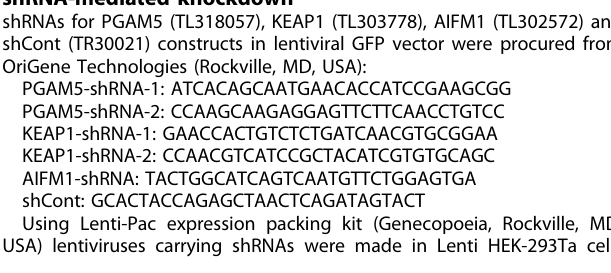
Fig. 7 Oxeiptosis is involved in SNG-induced tumor suppression in vivo. Mice were subcutaneously inoculated with HT-29 cells into the right fl anks and randomly divided into two groups ( n = 5). Mice were injected intraperitoneally (i.p.) with 6 mg/kg/ SNG or an equal volume of vehicle. A Individual value plot showing the weights of HT-29 tumor xenografts in the vehicle and SNG treatment groups. Data shown are mean ± SD ( n = 5) (** p < 0.01). B Tumor volumes of HT-29 xenograft tumors with the different time points (days) after exposure to SNG. Data shown are mean ± SD ( n = 5) (*** p < 0.001). C Western blot analysis of indicated proteins was performed. The signal intensities of western blot bands were normalized to AIFM1 of each group, and fold changes were plotted in a histogram from three independent experiments. Signi fi cant difference, * p < 0.05 D The relative body weight was evaluated during the treatment. Data shown are mean ± SD ( n = 5). E H&E- stained liver and kidney sections obtained from the mice treated with vehicle and SNG are shown. Scale bar: 100